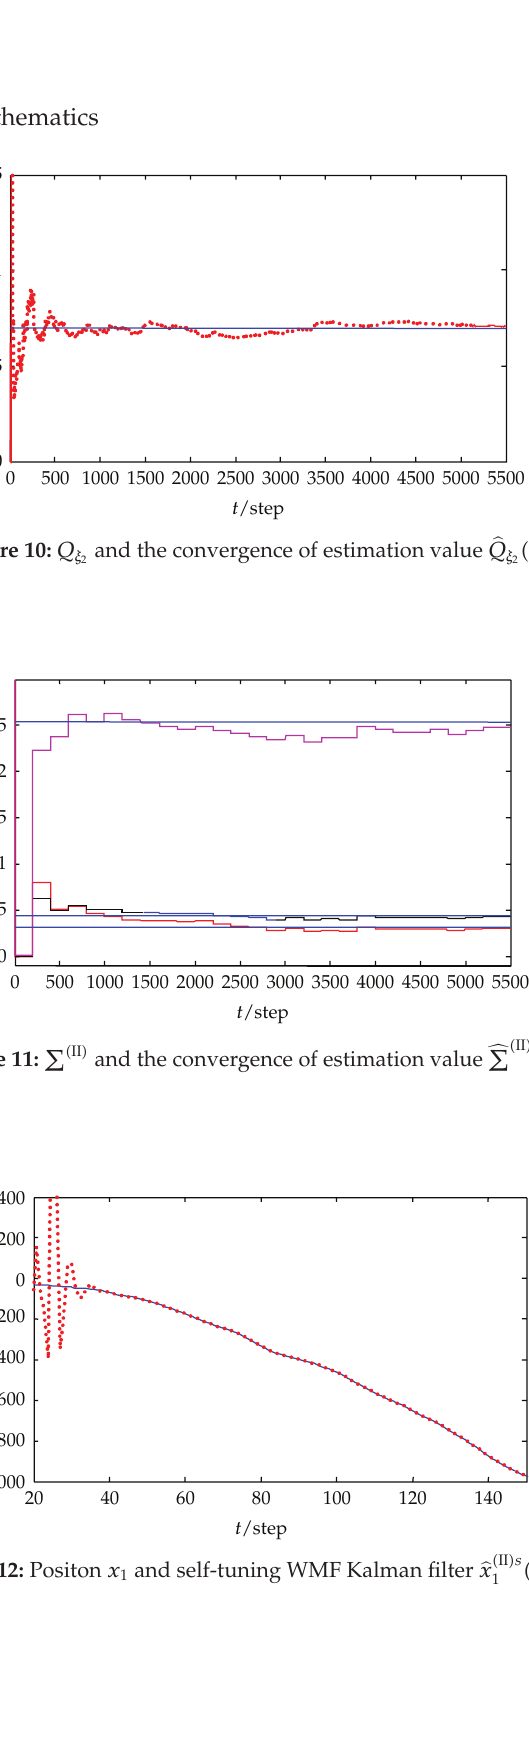
Figure 12: Positon x 1 and self-tuning WMF Kalman filter (cid:11) x